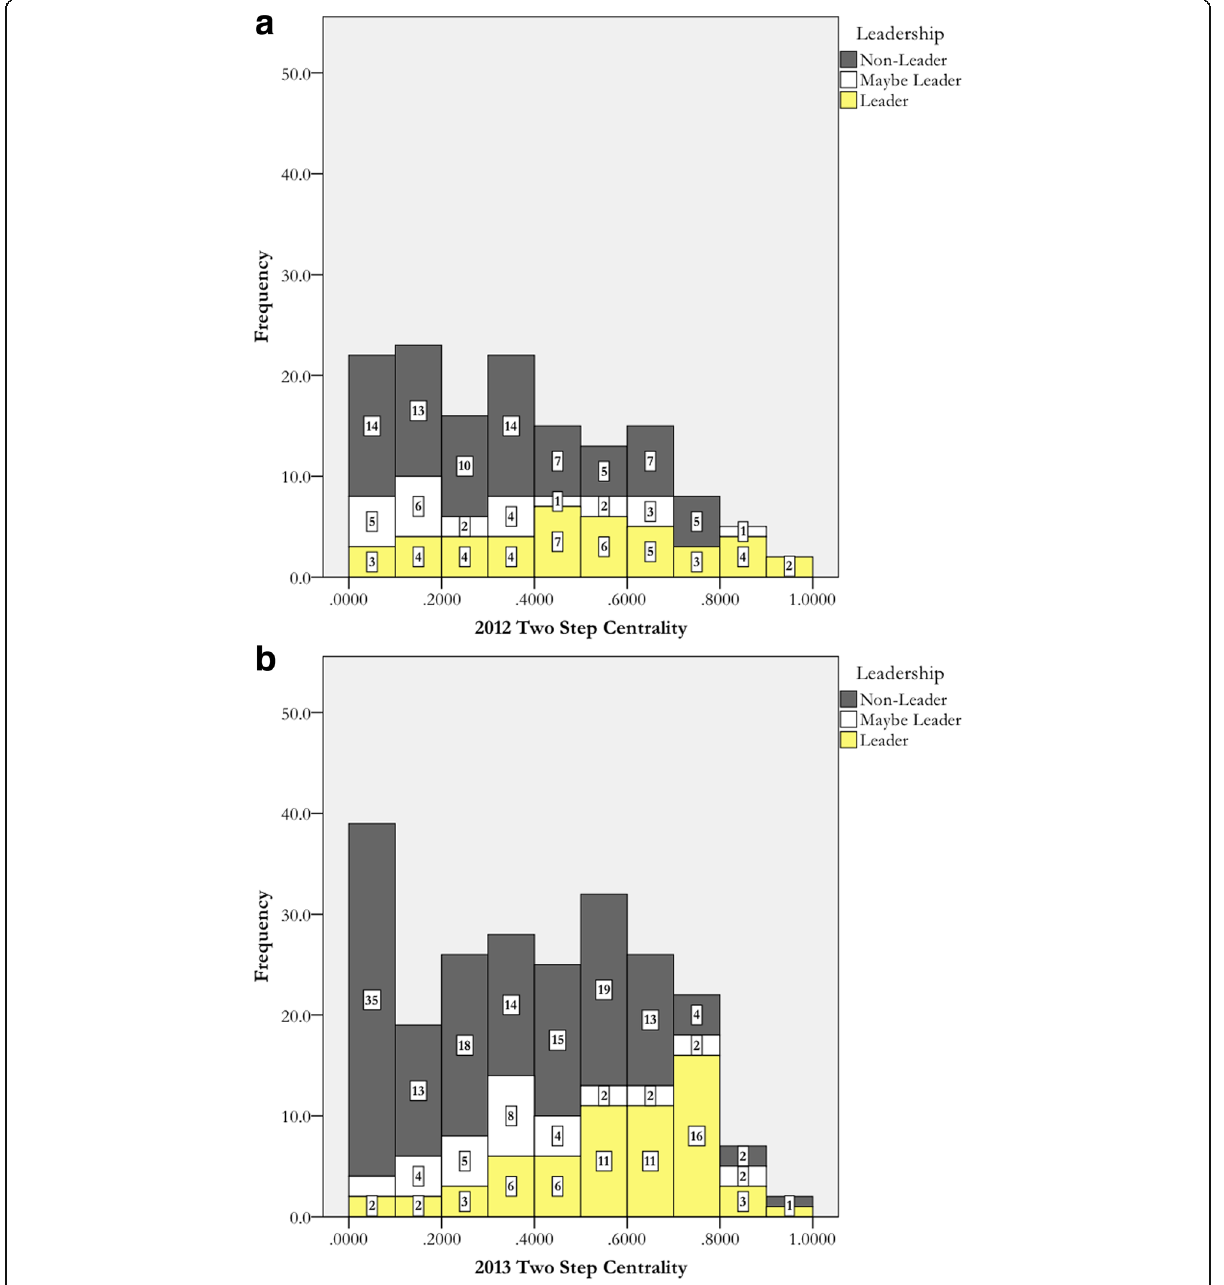
Fig. 3 Histograms depicting the distribution of two-step centralities and colored by leadership identity for 2012 ( a ) and 2013 ( b